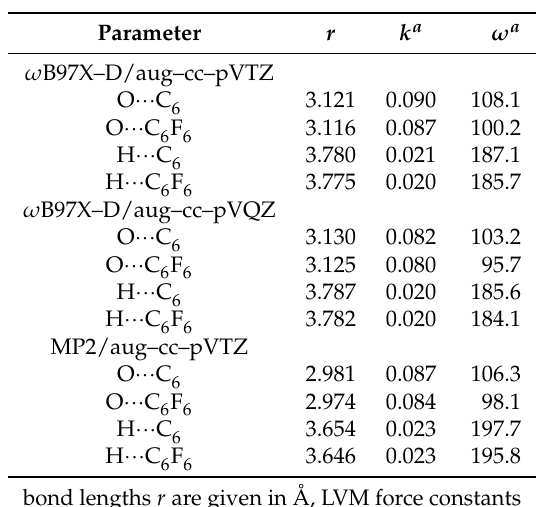
Table 2. Comparison of local vibrational mode LVM data for π –hole system 1 , where O ··· C (acceptor ··· donor) represents the pure π –hole interaction between the acceptor O–atom and the geometric center of the C–atoms comprising the six–membered ring, O ··· C but includes the six F–substituents of the π –hole donor, H ··· C with the geometric center of the six donor C–atoms, and H ··· C interaction with inclusion of the aryl